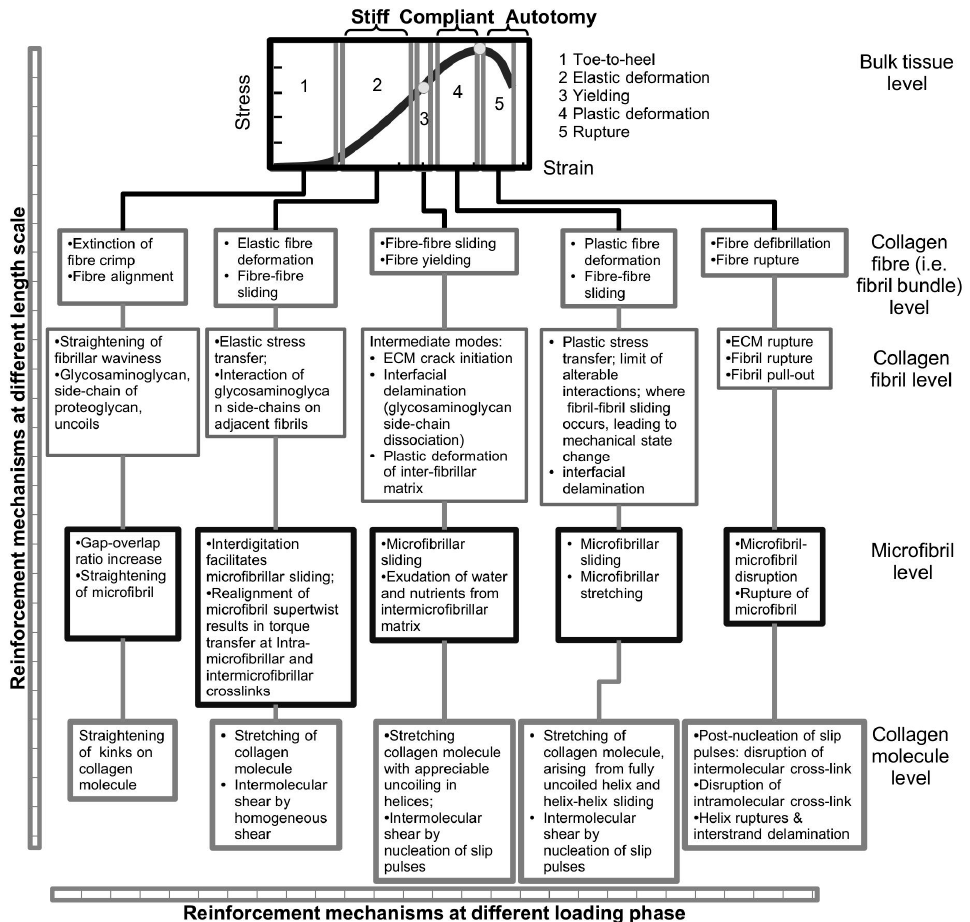
Figure 15. Framework of the ECM mechanics for the MCT [27]. The framework provides a systematic approach to map the mechanisms involve in regulating the mechanical response of ECM at the respective loading regimes, labelled 1–5. These mechanisms are identified across the length scale from molecular to bulk tissue level. At the tissue level, the graph illustrates a schematic representation of typical MCT stress-strain behaviour.